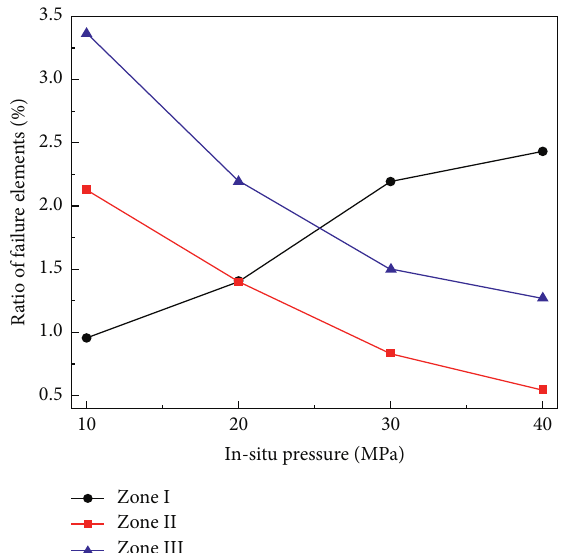
Figure 11: The ratio of failure elements as functions of in situ pressures.